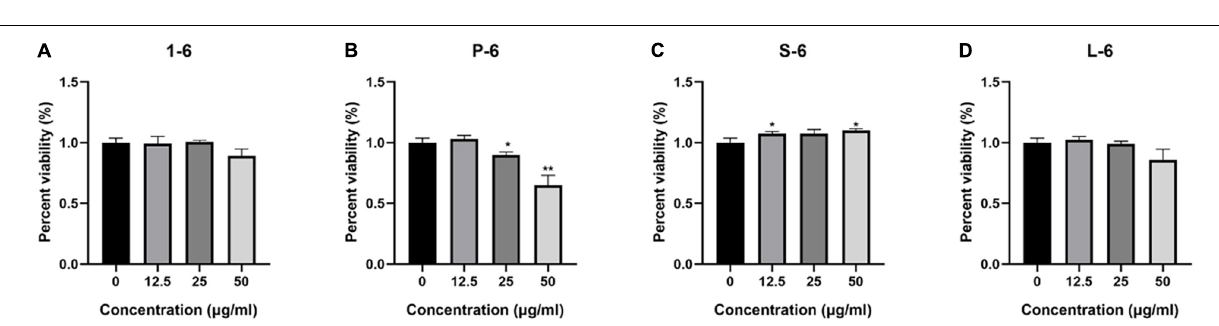
Antimicrobial Peptides 1–6, P-6, S-6,